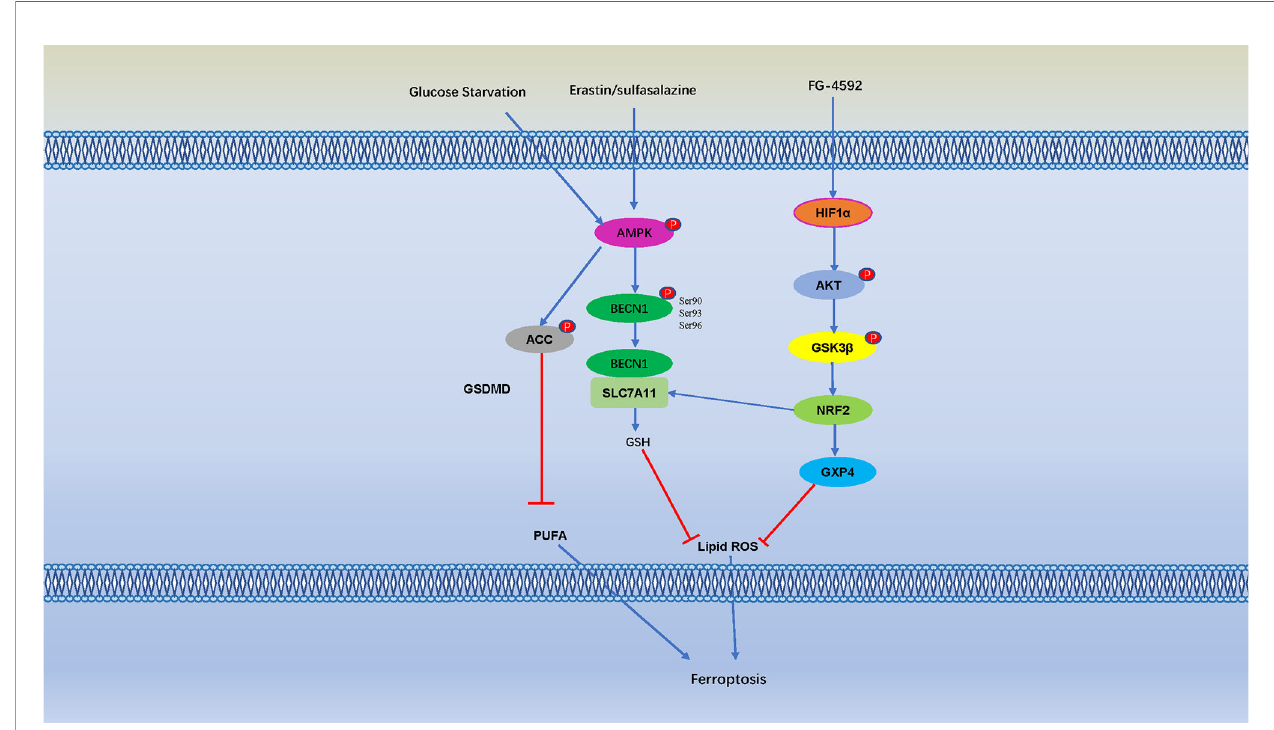
FIGURE 4 | Cell Ferroptosis is Regulated by Numerous Phosphorylation Events. AMP-activated protein kinase (AMPK) is a key sensor of cellular energy status, and glucose starvation leads to phosphorylation and activation of AMPK, AMPK mediated phosphorylation of Acetyl-CoA carboxylase (ACC) and inhibiting PUFA- containing lipid biosynthesis and negatively regulates ferroptosis. Erastin and sulfasalazine also activate AMPK phosphorylation, and AMPK phosphorylates BECN1 at Ser90/93/96, thereby promoting the formation of the BECN1-SLC7A11 complex (131). The interaction between BECN1 and SLC7A11 promote GSH, thereby inhibit lipid ROS and negatively regulates ferroptosis. Moreover, folic acid induced kidney damage was alleviated by pretreatment of FG-4592, which increased phosphorylated of protein kinase B (AKT) and glycogen synthase kinase 3 b (GSK-3 b ) and activated NFE2-related factor 2 (Nrf2) to inhibit